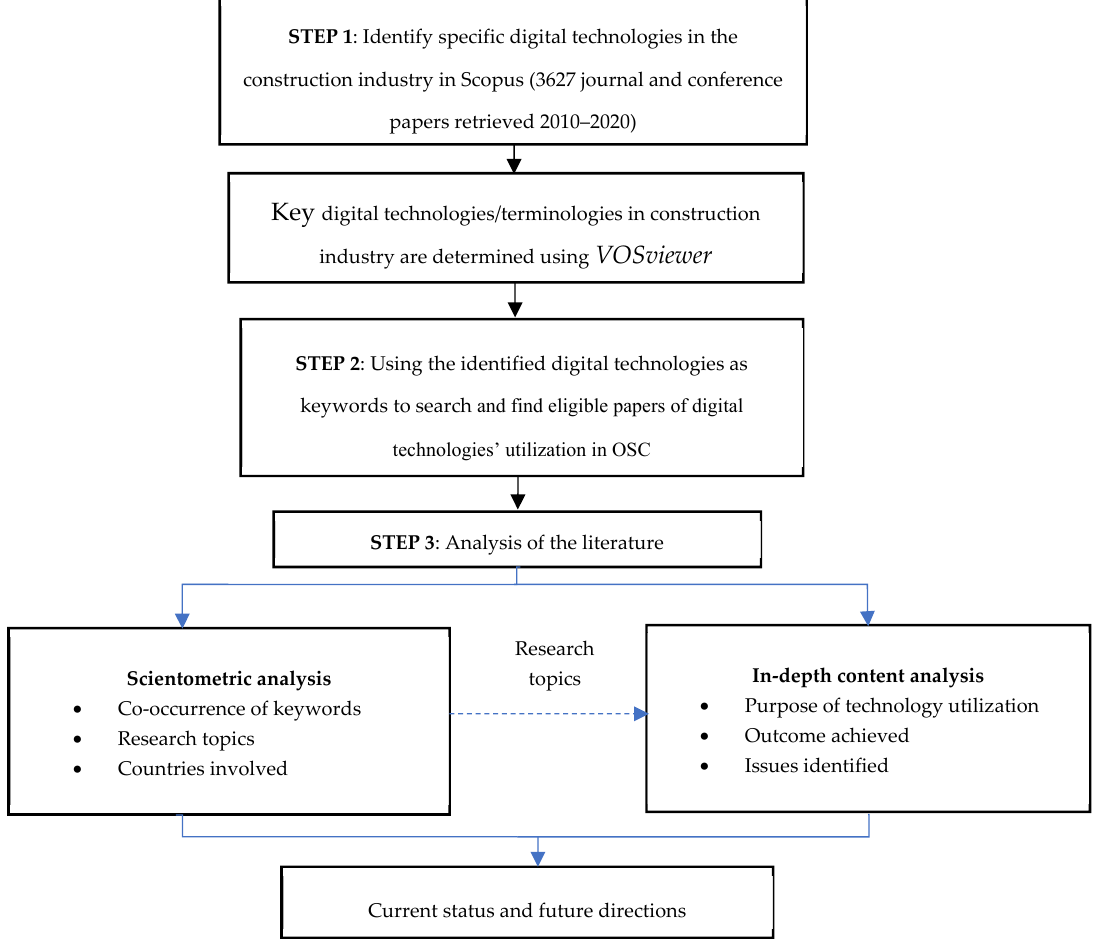
Figure 1. Systematic review process of digital technologies’ adoption in off-site construction (OSC).